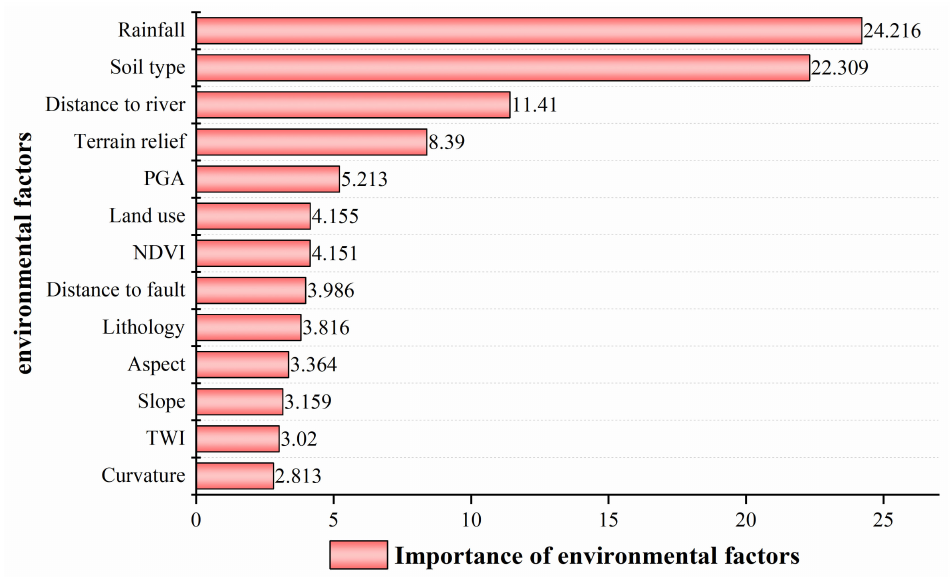
Figure 9. Importance Ranking of Environmental Factors of the CF-RF